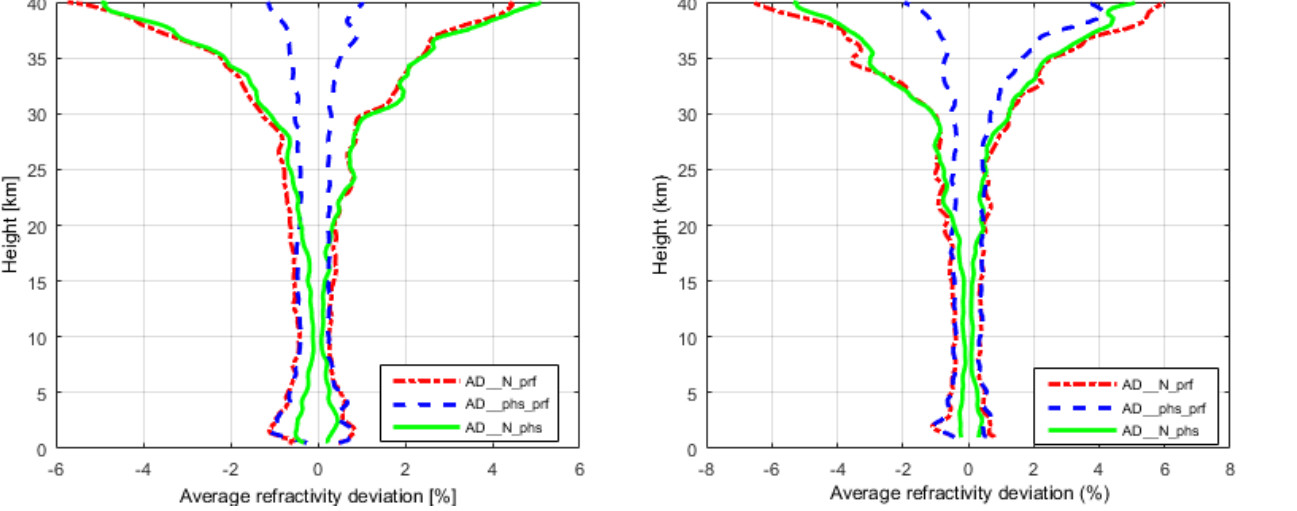
Figure 4. The statistical average relative deviation results of the re- fractivity for setting occultation events. AD_N_prf denotes the av- erage relative deviation of refractivity between R_N and atmPrf; AD_phs_prf expresses the average relative deviation of refractivity between R_phs and atmPrf; AD_N_phs represents average relative deviation of refractivity between R_N and R_phs; R_N is the refrac- tivity derived from ND-derived AEP for the selected 200 RO events based on ROPP software; Ref_Phs is the refractivity obtained from atmPhs profiles for the selected 200 RO events based on ROPP soft- ware.